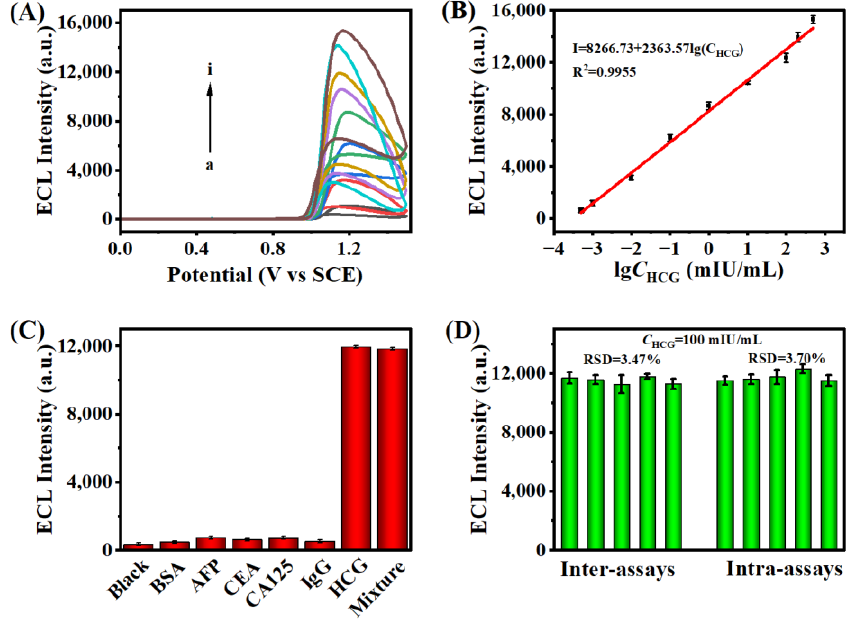
Figure 5. ( A ) ECL response with HCG of different concentrations (a to i: 0.0005 mIU/mL, 0.001 mIU/mL, 0.01 mIU/mL, 0.1 mIU/mL, 1 mIU/mL, 10 mIU/mL, 100 mIU/mL, 200 mIU/mL, 500 mIU/mL). ( B ) A linear relationship between the ECL intensities and lg C HCG . ( C ) Selectivity of the immunosensor with different interferences. ( D ) Reproducibility tests of the ECL immunosensor (intra-assays and inter-assays). (Error bars: SD, n = 3) in a solution of PBS (0.01 M, pH = 7.4) containing 50 µ M Ru(bpy) 32+ . The voltage of PMT was set at 800 V.